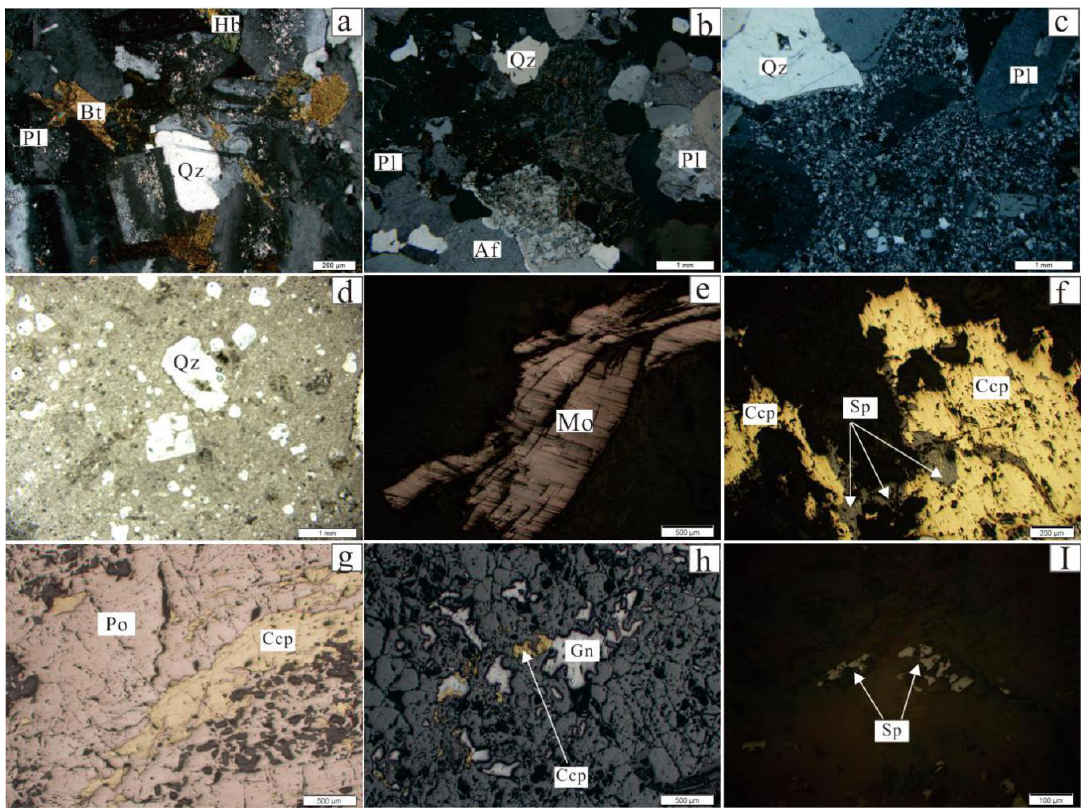
Figure 3. Photomicrographs of Hutouya deposit minerals: ( a ) granodiorite; ( b ) monzonitic granite; ( c ) granite porphyry; ( d ) crystal tuff; ( e ) molybdenite; and ( f – i ) samples used for S-Pb isotopic analyses.